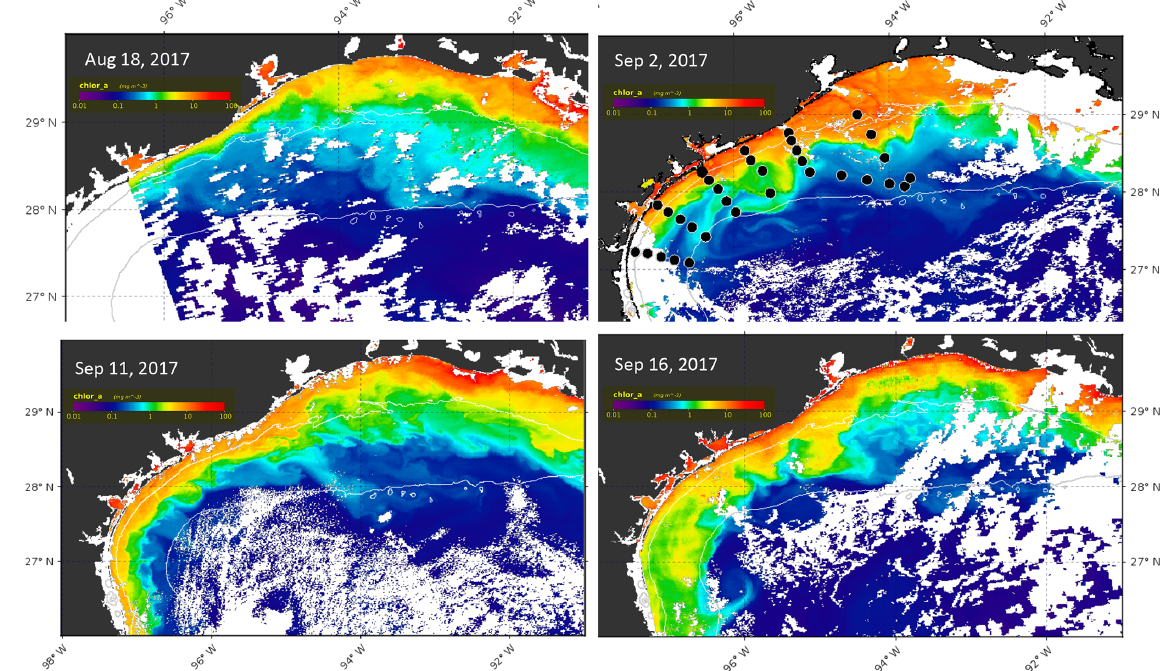
Figure 7. Aqua-1 MODIS imagery depicting chlorophyll a estimates for 18 August and 2, 11 and 16 September 2017. White areas along the Louisiana shelf and offshore are clouds. Thin white lines denote 20 and 100m isobaths. Station positions are indicated by the black dots in the 2 September